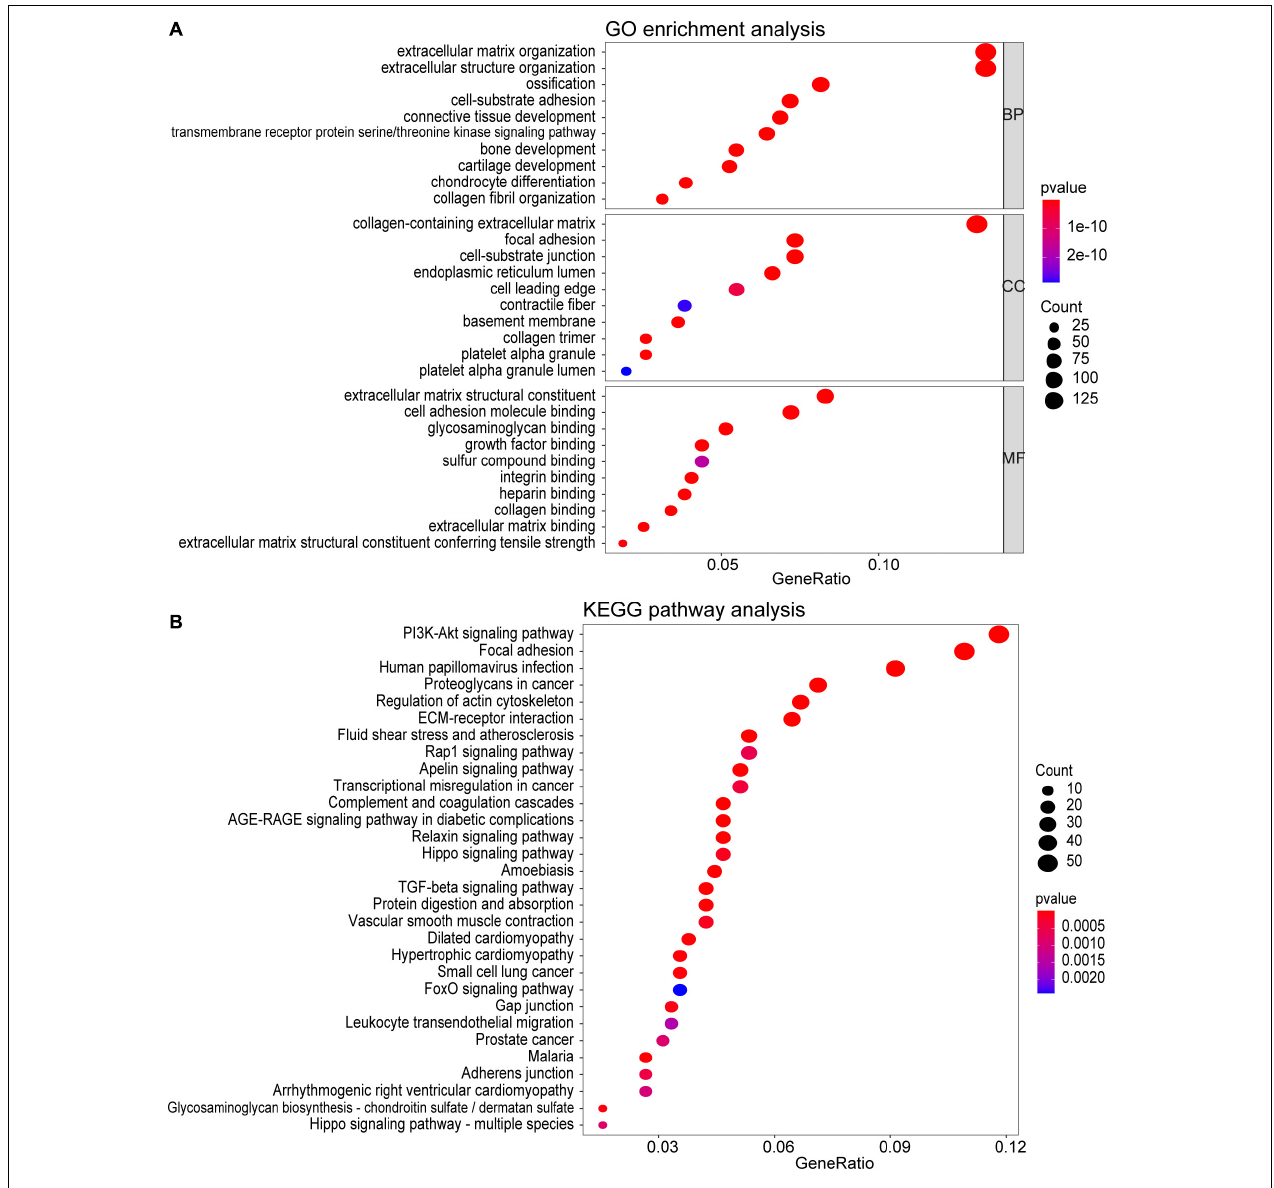
FIGURE 4 | Functional enrichment analysis of all the genes in the turquoise module. (A) GO enrichment analysis for biological process, molecular function, and cellular component. (B) KEGG pathway enrichment analysis. The colored dots represent term enrichment, blue indicates low enrichment, and red indicates high enrichment. The sizes of the dots represent the number of genes in each GO category and KEGG